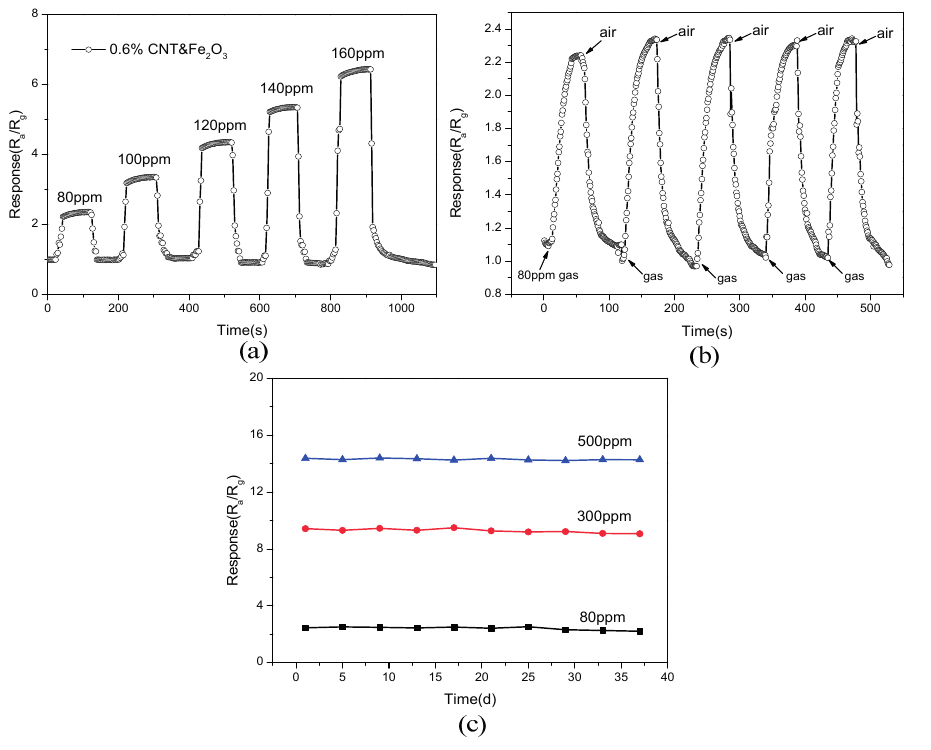
Figure 8. ( a ) Response of the sensor to acetone at low gas concentration; ( b ) The reproducibility of the sensor to 80 ppm acetone at 220 °C; ( c ) Stability of the gas sensor at 220 °C in different concentrations of